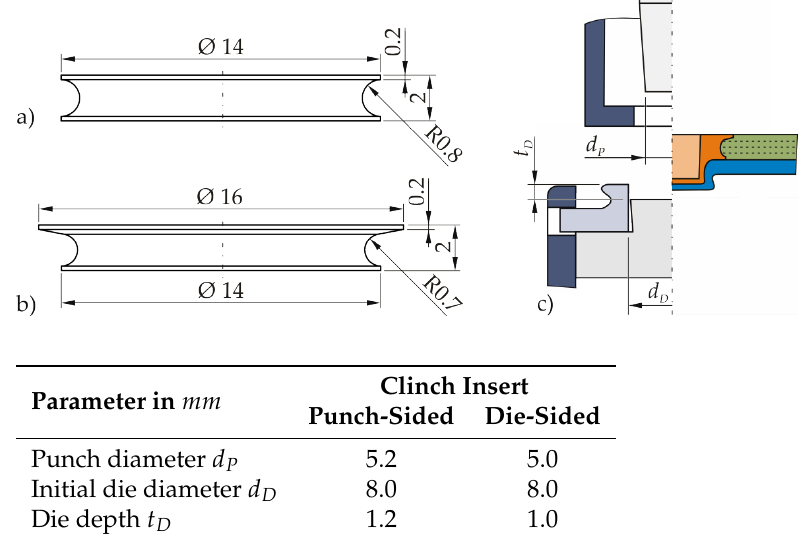
Figure 8. Characteristic dimensions of the used clinch inserts: ( a ) V1 and ( b ) V2 as well as ( c ) the clinching tool and